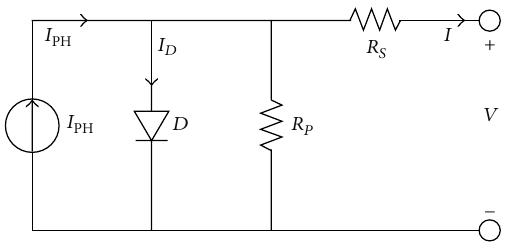
Figure 3: Equivalent circuit of the PV module.